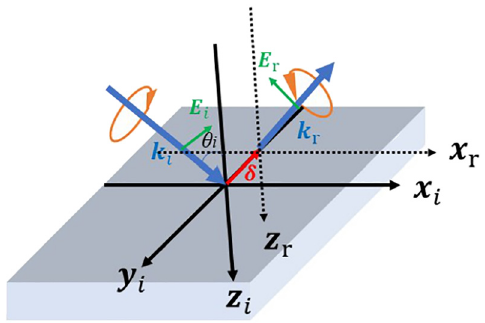
Figure 3: PSHE phenomenon of light reflection on the planar film